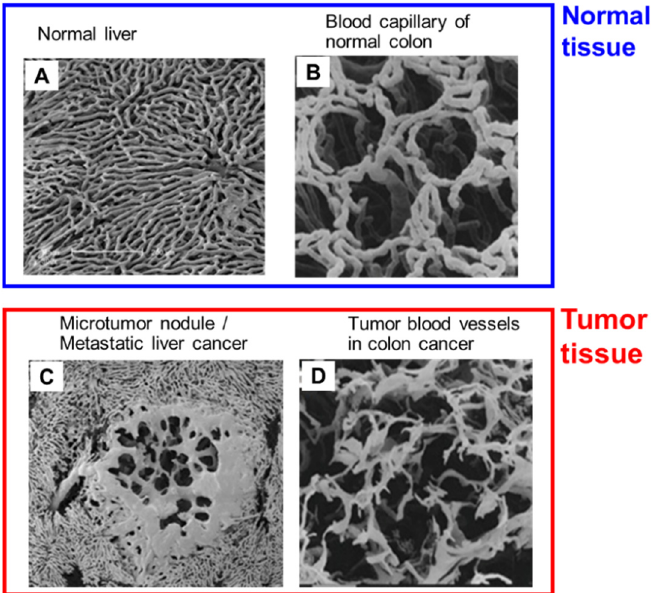
Figure 1. Comparison, via scanning electron microscopy (SEM), of a normal tissue blood vessel ( A , B ) and a tumor blood vessel ( C , D ) obtained from metastatic tumor nodules in the liver that originated from colon cancer. Blood vessels in normal liver ( A ) and healthy colon ( B ) show clear, smooth tight endothelial gaps and no leakage of polymeric resin. In contrast, tumor vessels, both in liver metastasis ( C ) and in colon cancer ( D ), show leaky blood vessels with irregular features. These SEM images were taken and modified from ref. [44].